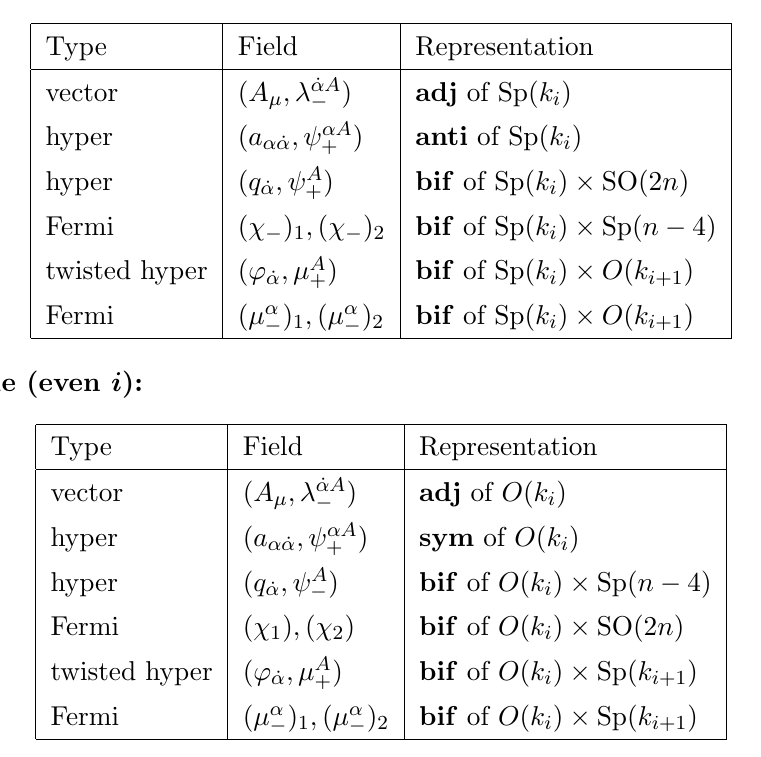
Table 1. Field contents of 2d gauge theories on D2-branes. The index i is taken modulo 2 N . gauge node, which counts the number of the i -th fractional little strings. F i;‘ the Cartan generators of i -th gauge group of rank r i . We introduce a fugacity variable for each combination of the Cartan generators that commutes with Q and Q y . Besides k i